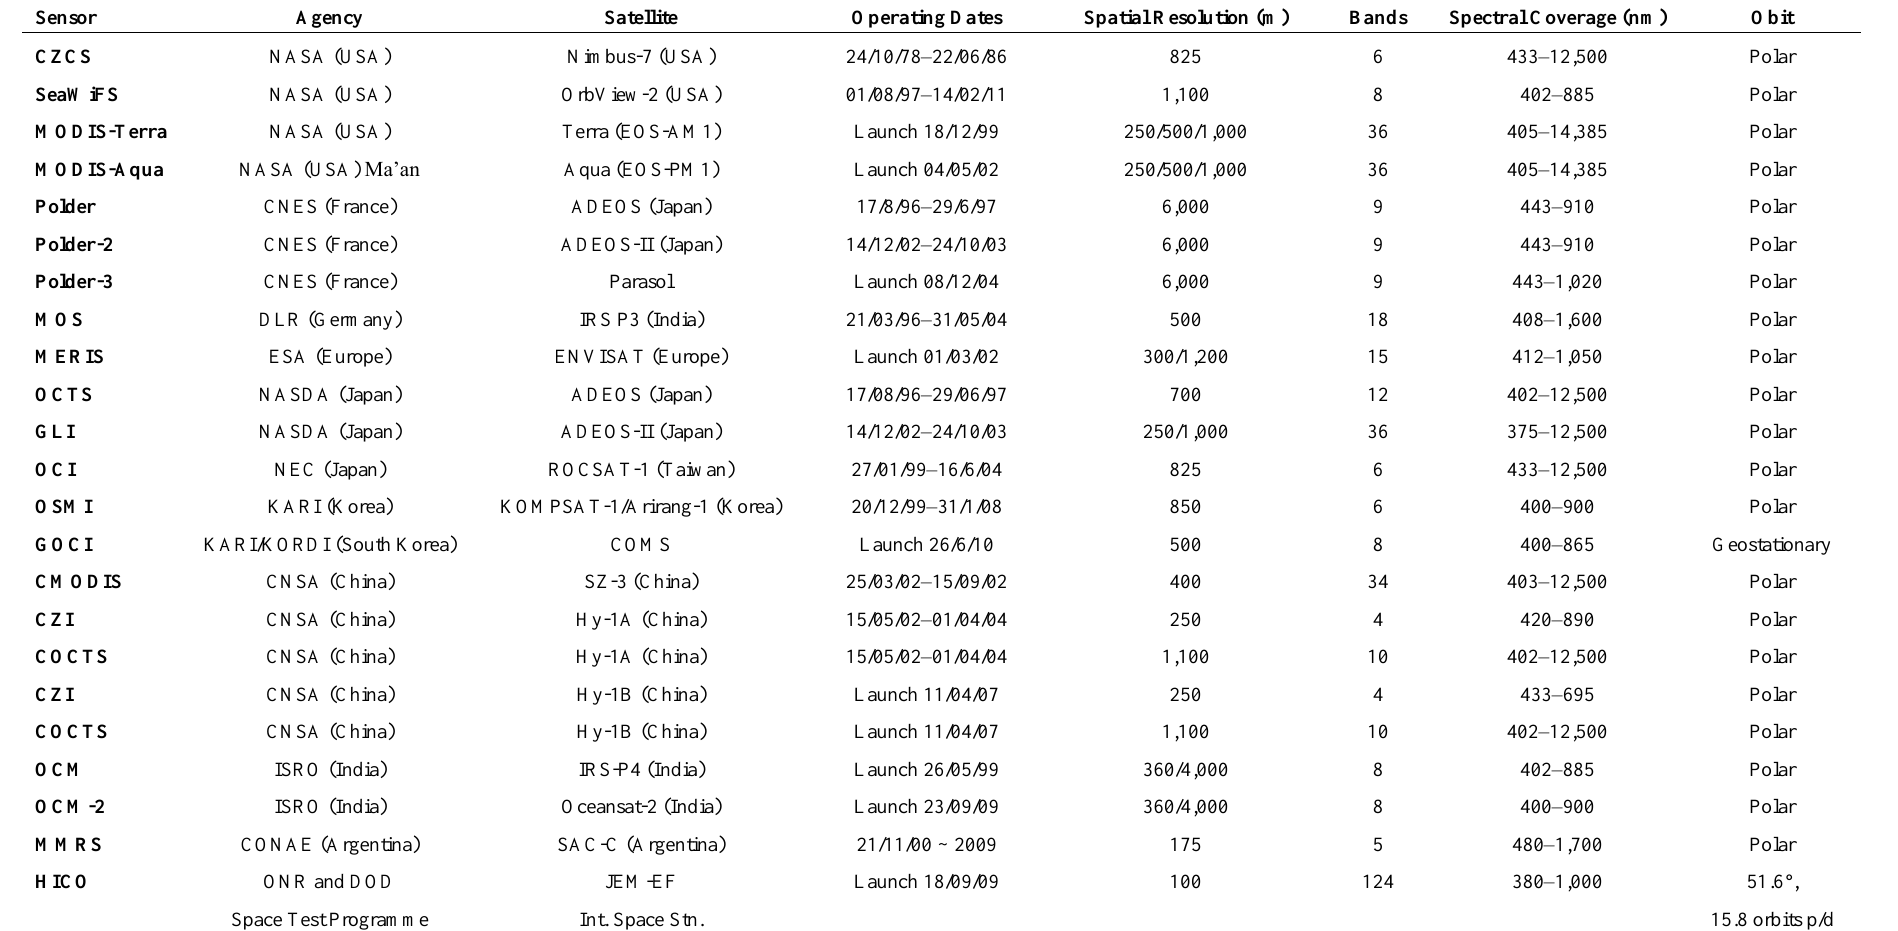
Table 1. Characteristics of historical and current ocean-color sensors (International Ocean Color Coordinating Group. http: